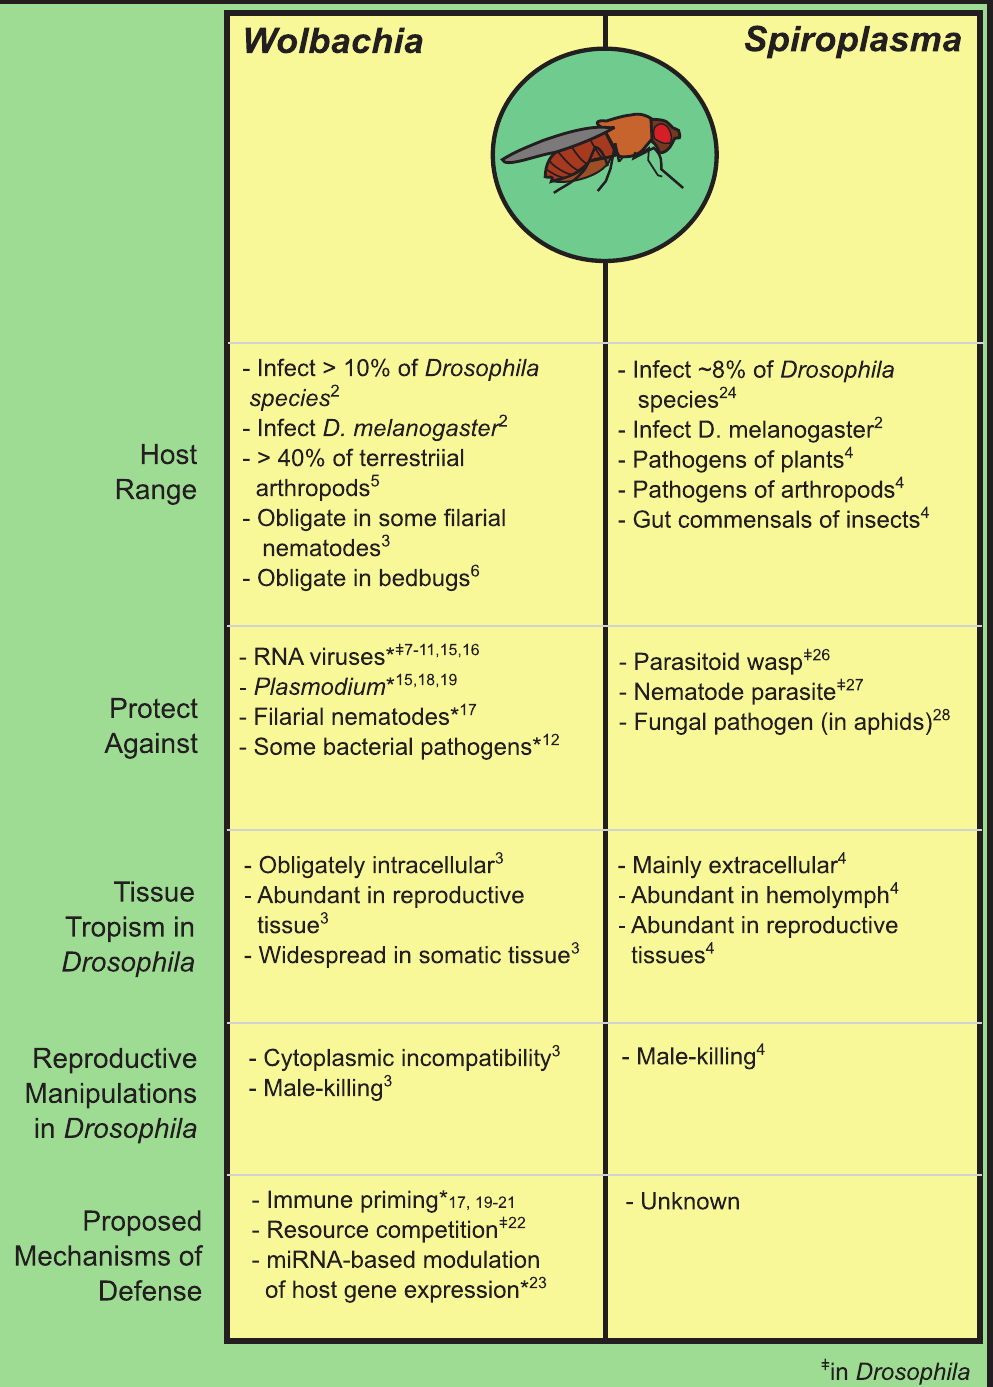
Figure 1. The inherited symbionts of Drosophila .